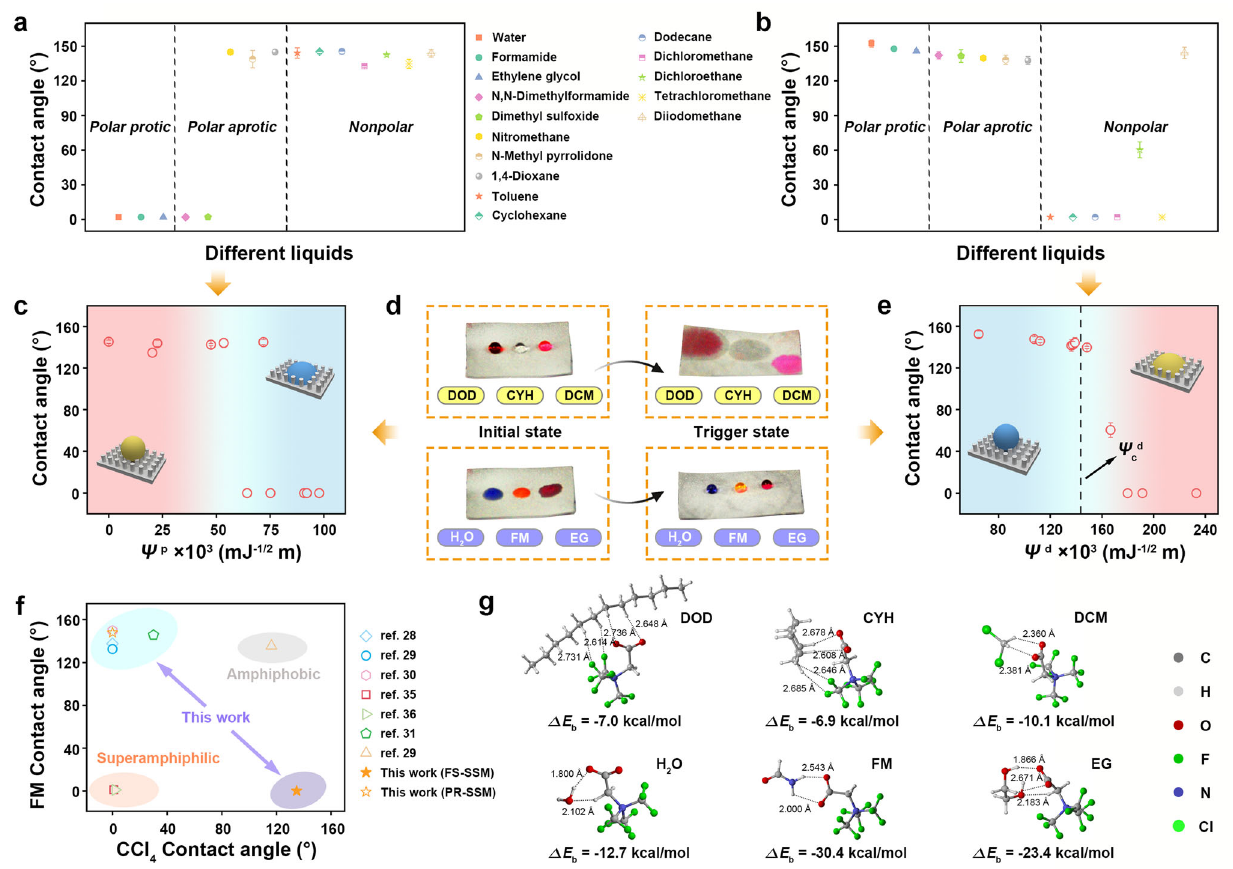
Fig. 3 Wetting transition behaviors of the membranes. a Contact angles on the FS-SSM for various OLs including polar protic liquids, polar aprotic liquids, and nonpolar liquids. b Contact angles on the PR-SSM for above OLs. c Dependence of contact angle on the Ψ p of the corresponding liquids (FS-SSM, each data is explained in Supplementary Table 4). d Left section: Digital photographs of different liquid droplets on the FS-SSM including dodecane (DOD), cyclohexane (CYH), and dichloromethane (DCM), water, formamide (FM), and ethylene glycol (EG); Right section: Digital photographs of the corresponding liquid droplets on the surface after the trigger of ethanol. e Dependence of contact angle on the Ψ d of the corresponding liquids (PR-SSM, each data is explained in Supplementary Table 5). f Comparison of wetting performance of our membranes with some other notable reported membranes in the literature, taking formamide (FM) and tetrachloromethane (CCl 4 ) as the research models. g Optimized geometries of model OL molecules binding with the amphoteric fl uorosurfactant molecule by the density functional theory (DFT) calculations and the corresponding binding energy ( Δ E b